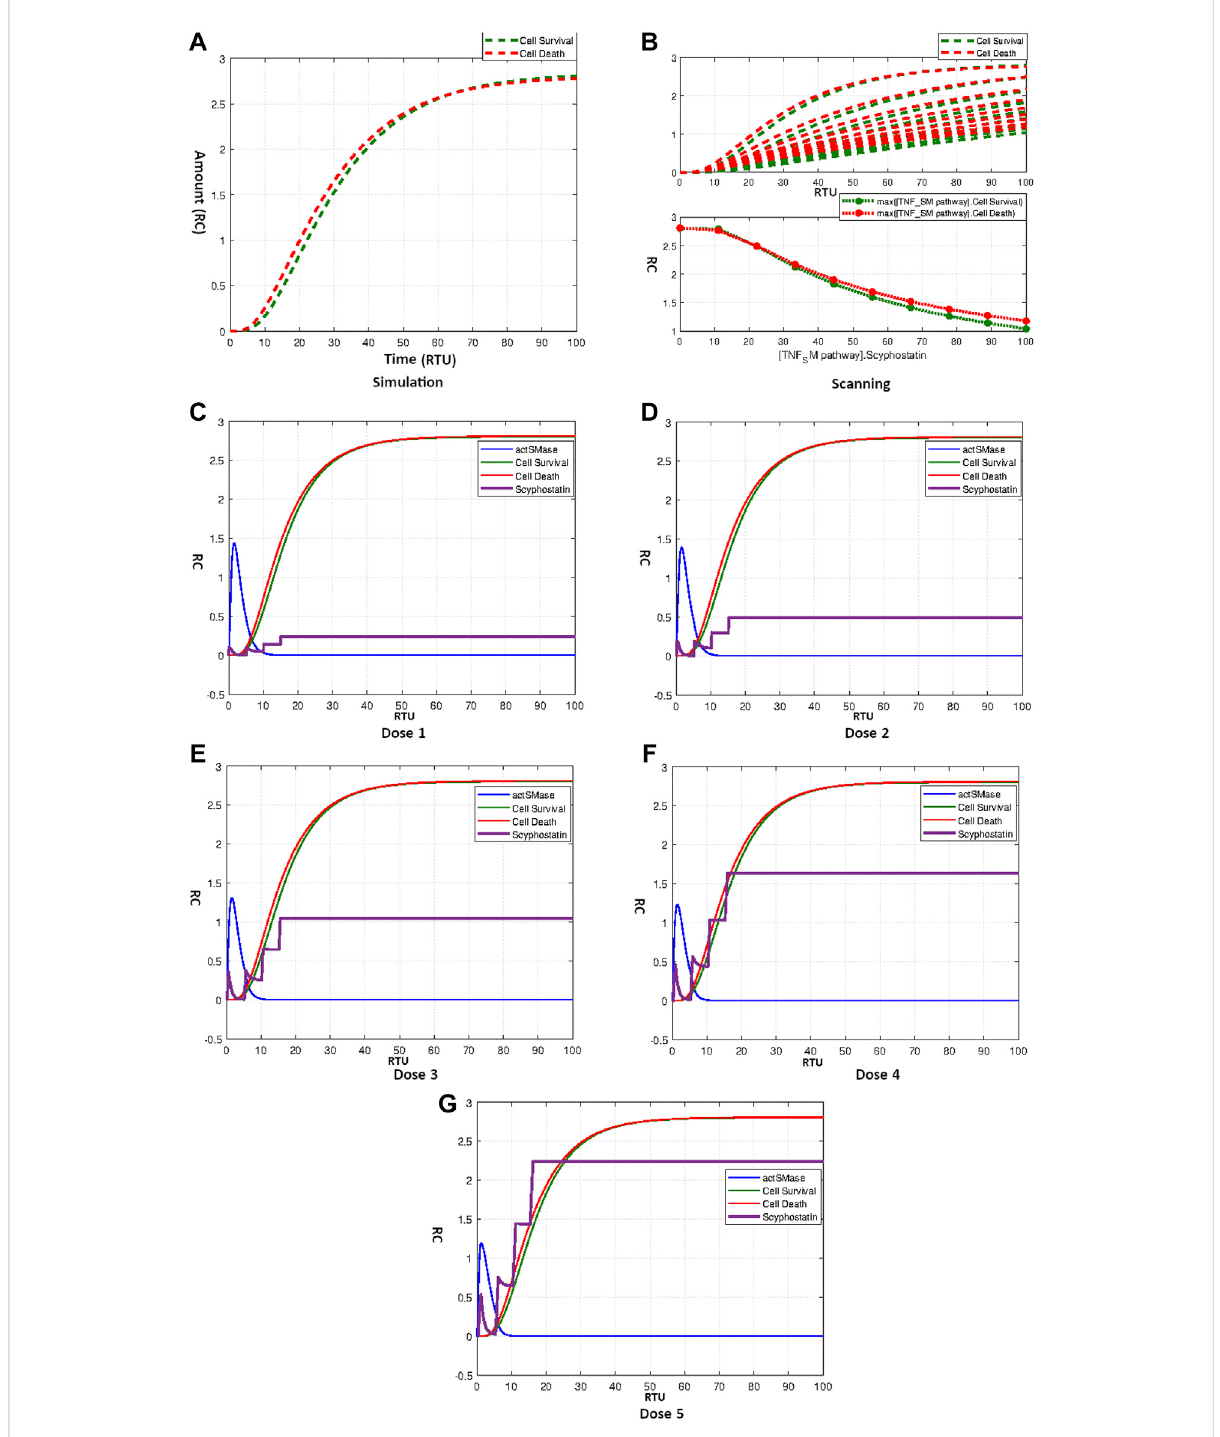
FIGURE 11 (A) Simulation showing effect of Scyphostatin on Neuronal Survival and Death. (B) Scanning of Scyphostatin. (C – G) Figures c to g represent the dosage graphs for Scyphostatin according to Table 4. Dosage (C – G) have no obvious effect on neuronal death and